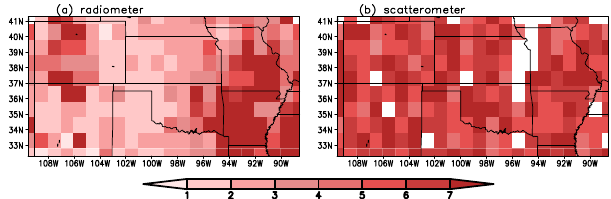
Fig. 4. The root mean square error (RMSE, % vol/vol) between the truth and soil moisture retrieval composites for (a) radiometer (left) and (b) scatterometer (right) from September 2002 to Septem- Fig.4. Therootmeansquareerror(RMSE,%vol/vol)betweenthetruthandsoilmoistureretrievalcomposites ber fora)radiometer(left)andb)scatterometer(right)fromSeptember2002toSeptember2003.